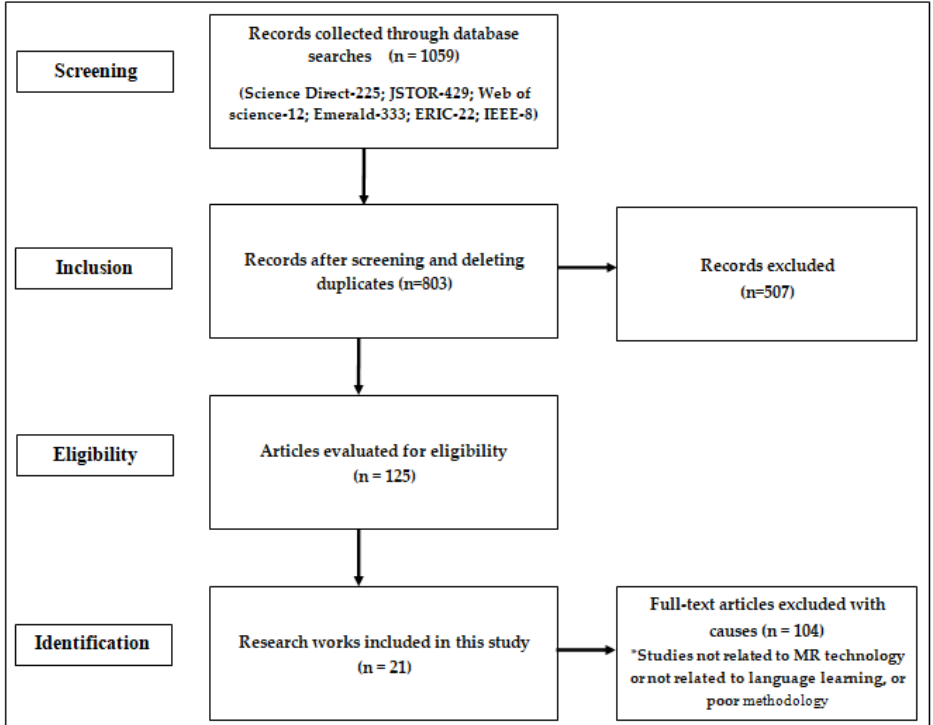
Figure 1. The PRISMA